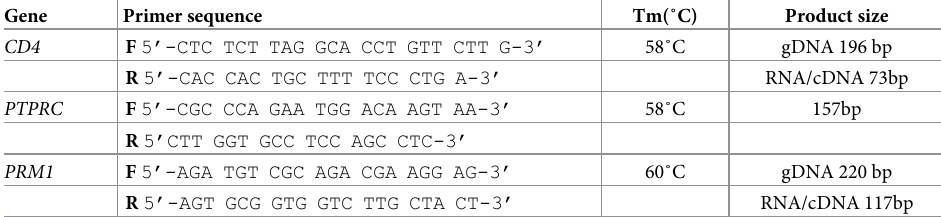
Table 3. Ovine-specific primer sequences for PCR and qPCR amplifications of CD4 , PTPRC and PRM1 genes, PCR melting temperatures and product